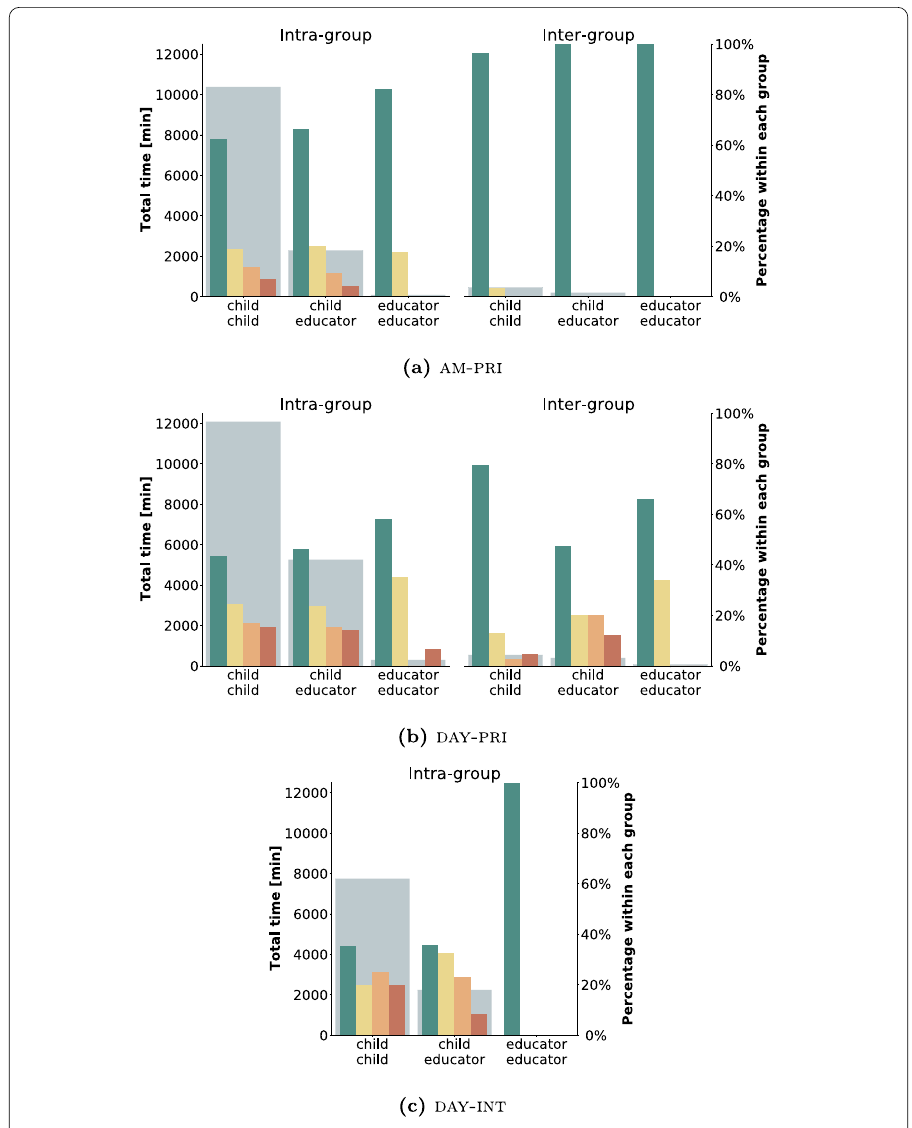
Figure 6 Social bubble policy and roles. Distribution of risk levels by group and type of interaction for each summer camp. The color bars, which refer to the right-hand scale, report the percentage of time of contact within each risk level. The grey background bars, which refer to the left-hand scale, report the total time of contact for each of the six